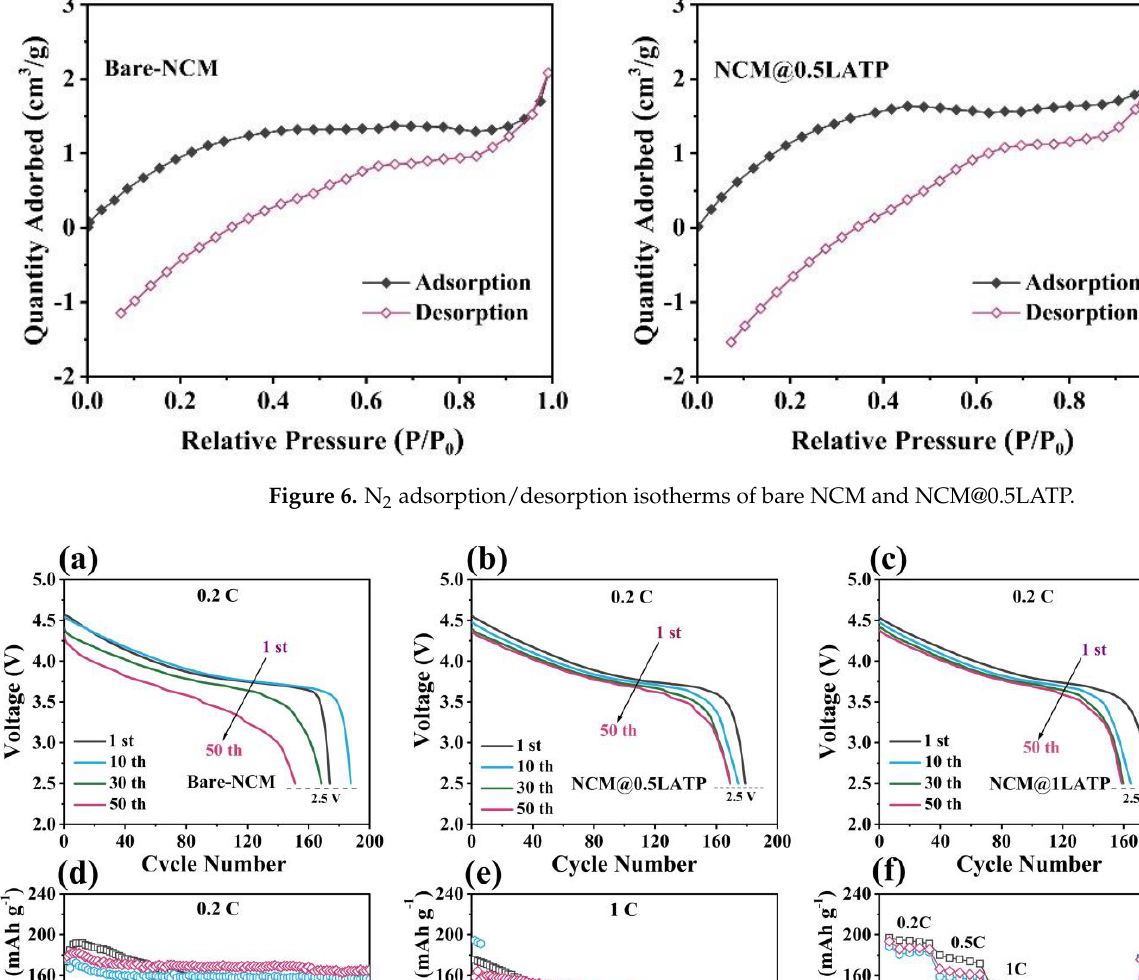
Figure 7. Discharge profiles of ( a ) bare NCM, ( b ) NCM@0.5LATP, and ( c ) NCM@1LATP; cycle performance of the three samples at ( d ) 0.2C and ( e ) 1C rate; ( f ) rate performances of the three samples. To reveal the effect of the LATP layer on the electrochemical internal resistances, EIS experiments were performed on bare NCM and NCM@0.5LATP (Figure 8). The Nyquist curves of the two samples are similar. The equivalent circuit model used for fitting is shown in the inset. R1 in the model represents the Ohmic resistance, which may mainly come from the electrolyte, while R2 represents the charge transfer resistance. Table 1 shows the fitted parameters. According to the data, R2 of the bare NCM is 93.1 Ω be fore cycle, and increases to 146.7 Ω after 50 cycles, with a growth rate of 57.6%. While for NCM@0.5LATP, R2 increases from 59.6 Ω to 75.3 Ω, with a growth rate of only 26.3%. This result indicates the surface layer of NCM@0.5LATP is much stable than that of the bare NCM. The reason may be the protective layer prevents the side reactions of the electrolyte from occurring, and forms a stable cathode – electrolyte interphase, which provides a bet- ter microporous channel for lithium-ion diffusion [13,14].